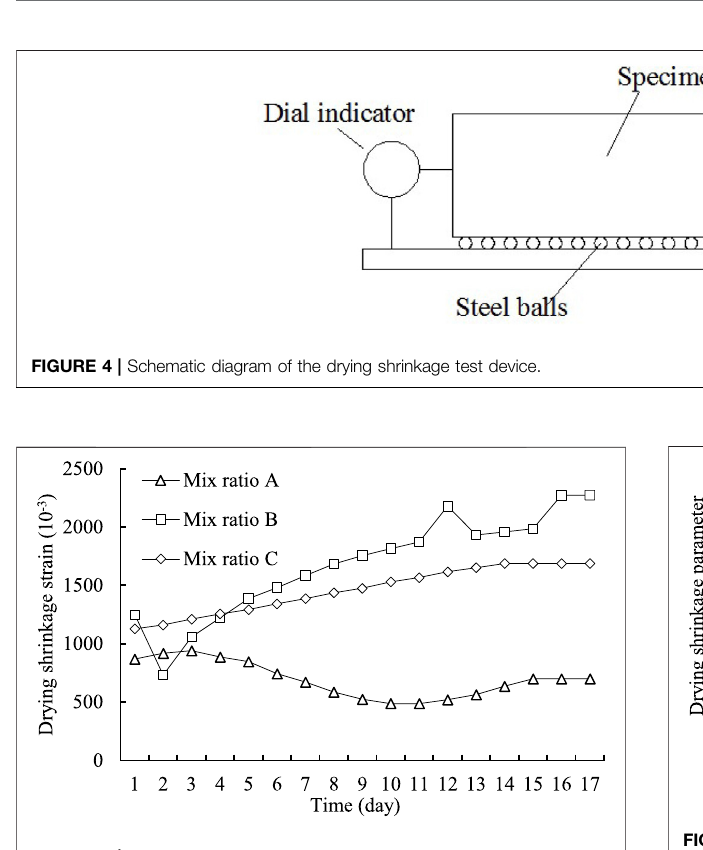
FIGURE 5 | Relationship between drying shrinkage strain and time.